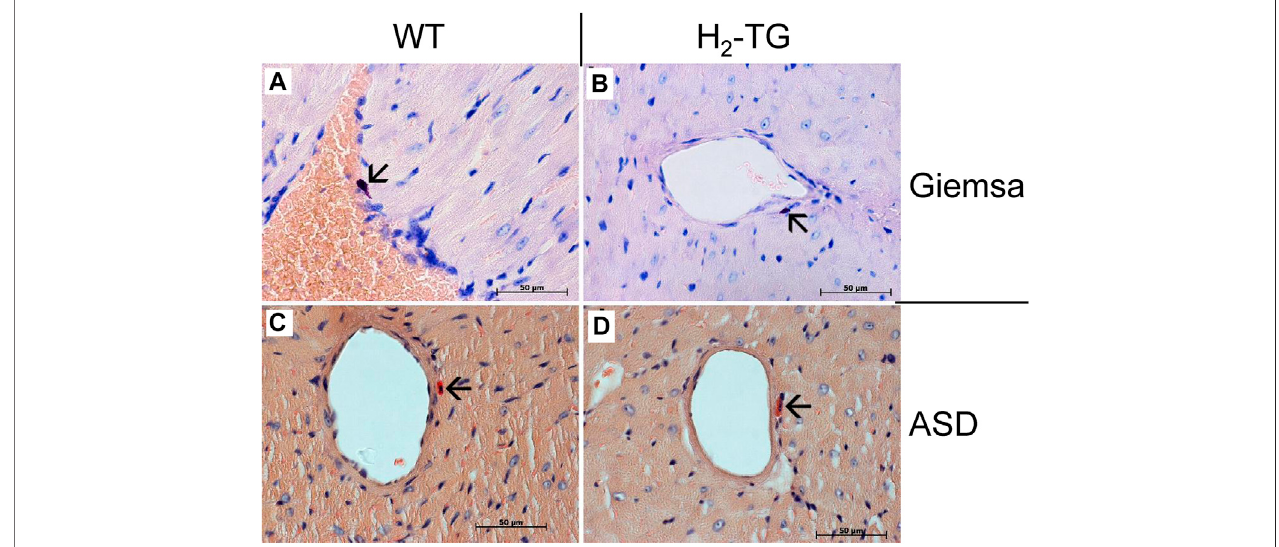
FIGURE 9 | Analyses of mast cells in the mouse myocardium. Localization of mast cells was performed by Giemsa stain (A,B) of the myocardium of WT mice (A) and H 2 -TG mice (B) as well as by ASD-Chloracetate-Esterase activity (C,D) , characteristic for mast cells, in the myocardium of WT mice (C) and H 2 -TG mice (D) . These representative pictures demonstrate the rare occurrences of mast cells in the mouse myocardium. Mast cells are marked with arrows. Nuclei are counterstained with haematoxylin. Horizontal bars indicate 50